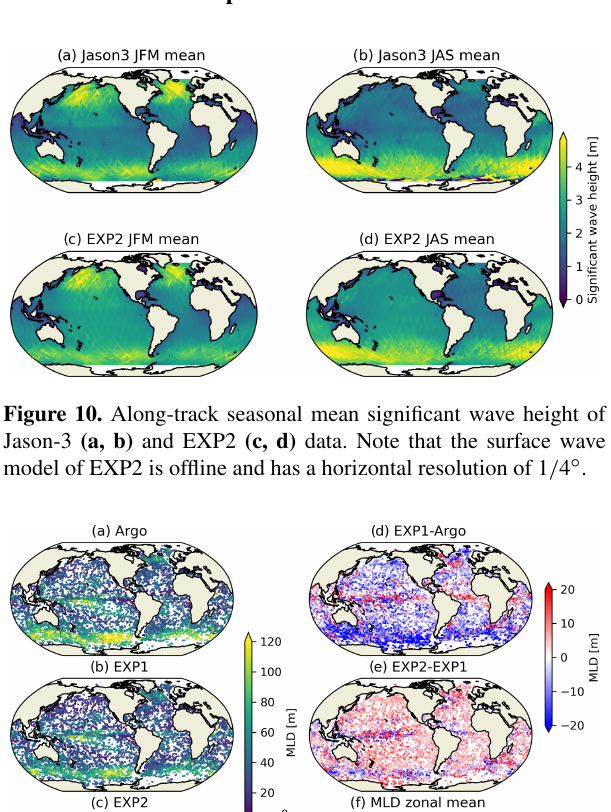
filtered Jason-3 data for the comparison, and the global mean RMSE of the simulated SWH in 2018 and 2019 is 0.57 m.